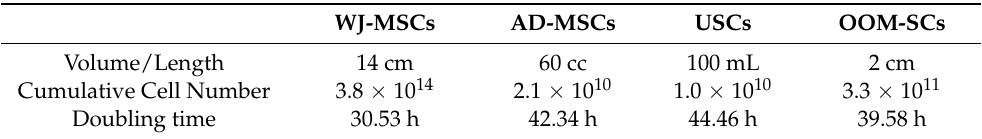
Table 2. Comparison of WJ-MSCs, AD-MSCs, USCs, and OOM-SCs in the cumulative cell number and doubling time in correlation with the volume of tissue of origin.